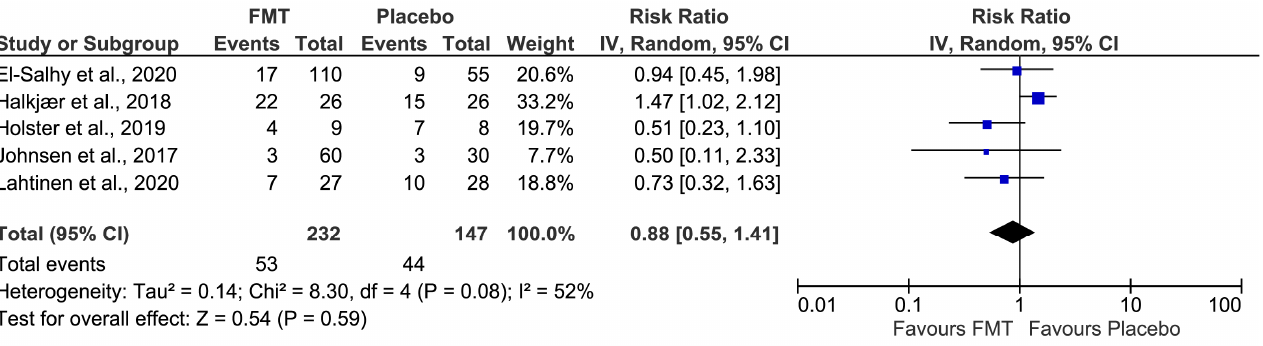
Figure 4. Forest plot of adverse events. El-Salhy et al., 2020 [32] , Halkjær et al., 2018 [33] , Holster